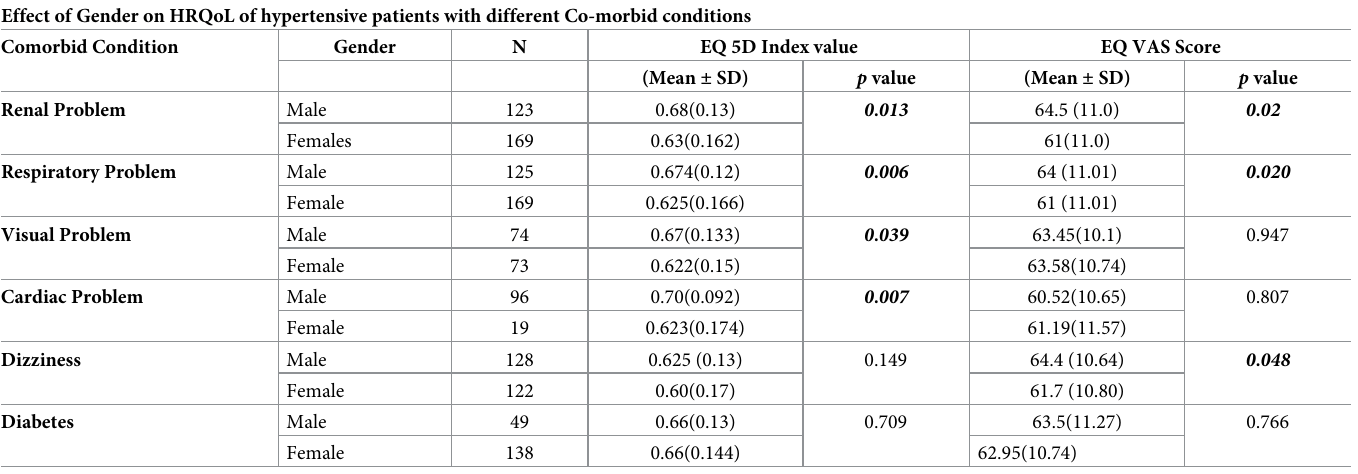
Table 5. Effect of gender on HRQoL of hypertensive patients with different Co-morbid conditions. Effect of Gender on HRQoL of hypertensive patients with different Co-morbid